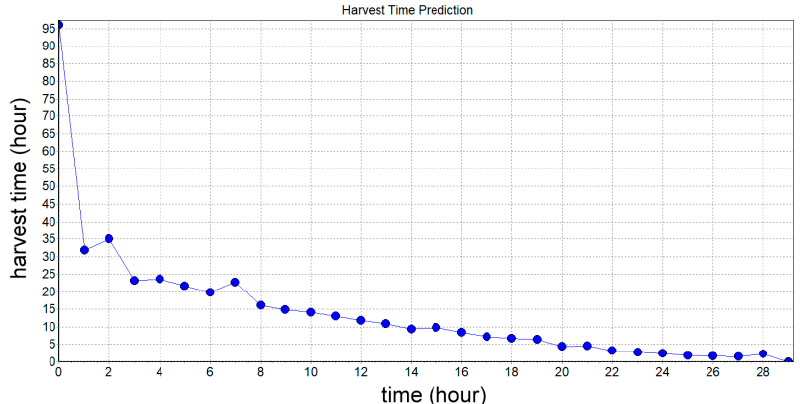
Figure 11. The estimated harvest time in 29 h.